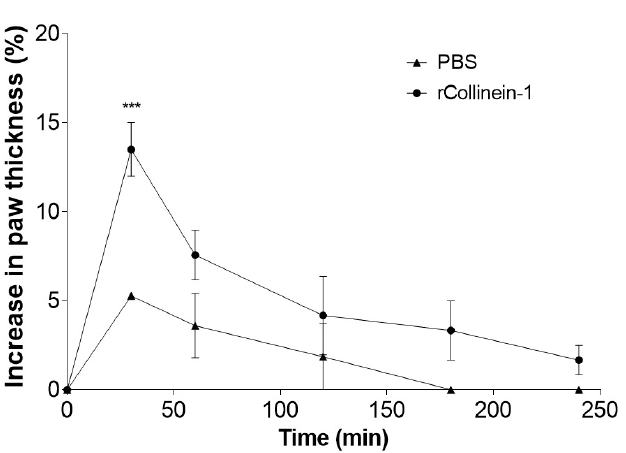
Figure 2. Edematogenic activity of rCollinein-1. Male Swiss mice were divided into two groups of four animals each. One group was treated with rCollinein-1 (10 μg diluted in 50 μl PBS) by subplantar injection in the left hind paw. The other group was treated with PBS as a negative control. Paw thickness was measured with a low-pressure plethysmometer. Data were expressed as means ±S.E.M. from four separated experiments. *** p <0.001 compared to the negative control.